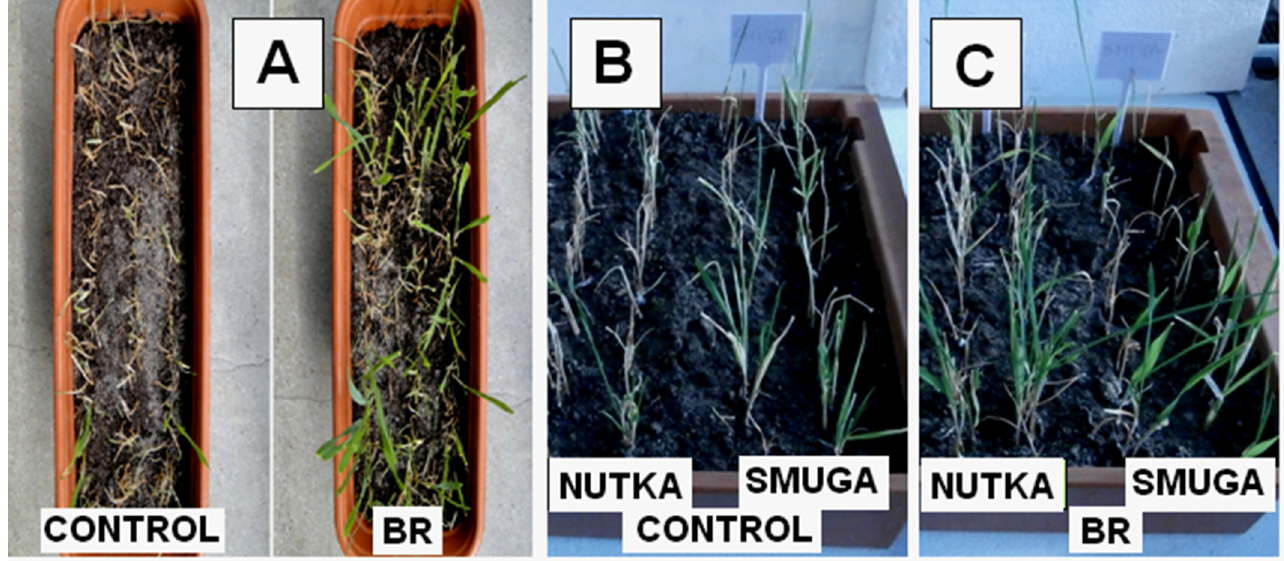
Figure 2. After-frost regrowth of the winter cereals that had been pretreated with brassinosteroids (BR). ( A ) Winter rye plants of the cold-acclimated control after exposure to − 17 °C (left) and plants that had been sprayed with BR (24-epibrassinolide) before cold acclimation and then exposed to − 17 °C (right) (based on Pociecha et al. [88], photo courtesy of E. Pociecha). Winter wheat (cultivars Nutka and Smuga): control plants that had been cold acclimated and then exposed to − 12 °C ( B ), plants that had been sprayed with BR (24-epibrassinolide) before cold acclimation and then exposed to − 12 °C ( C ) (based on Janeczko et al. [89]).